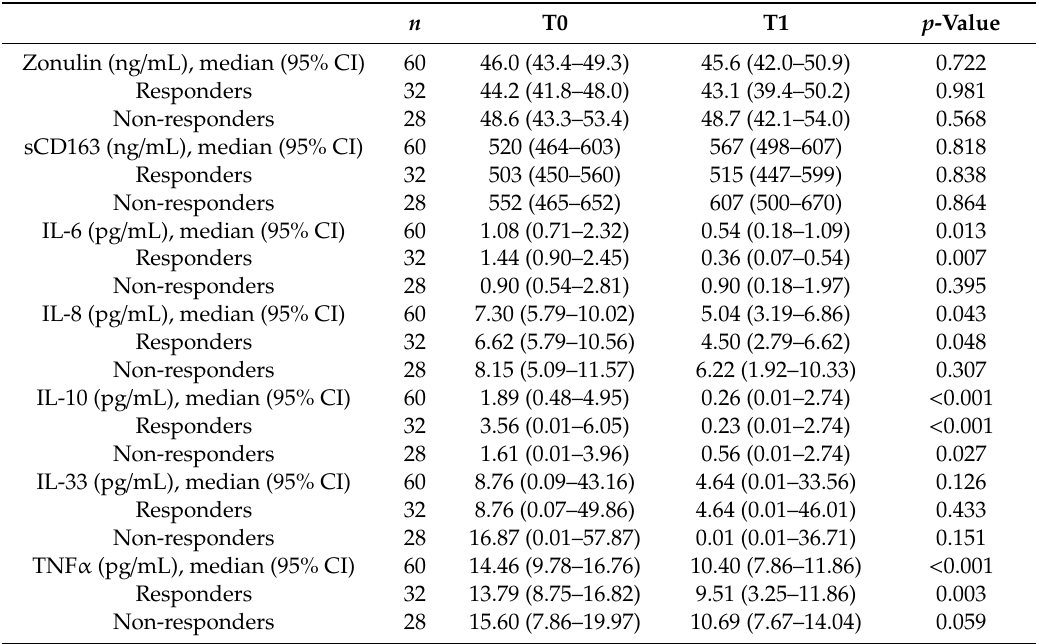
Table 3. Comparison between baseline (T0) and 10 weeks (T1) values of zonulin, sCD163, and cytokines in the 60 IBD patients treated with biologic therapy and according to treatment